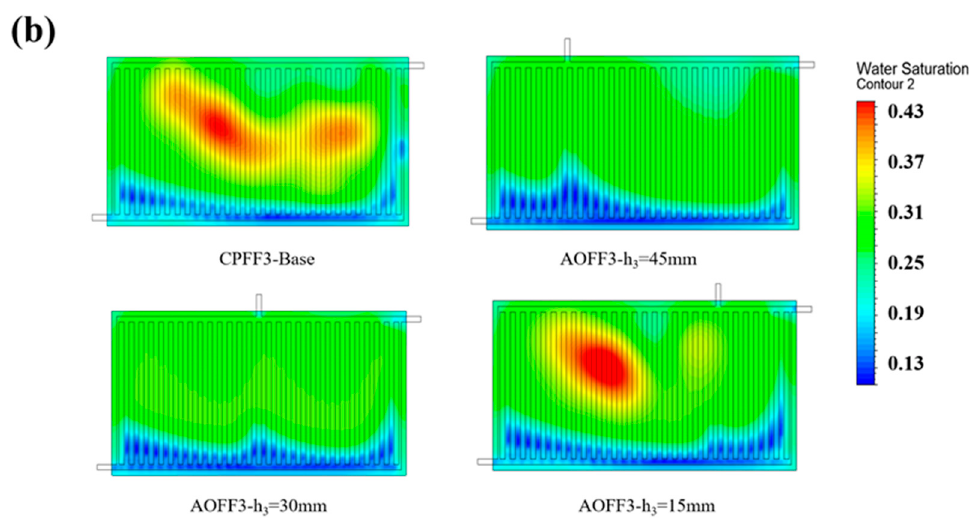
Figure 12. Water saturation on the cathode CL–GDL interface at Vcell = 0.5 V. ( a )The proportion is 4.5 cm 2 ( b ) The proportion is 18 cm 2 .